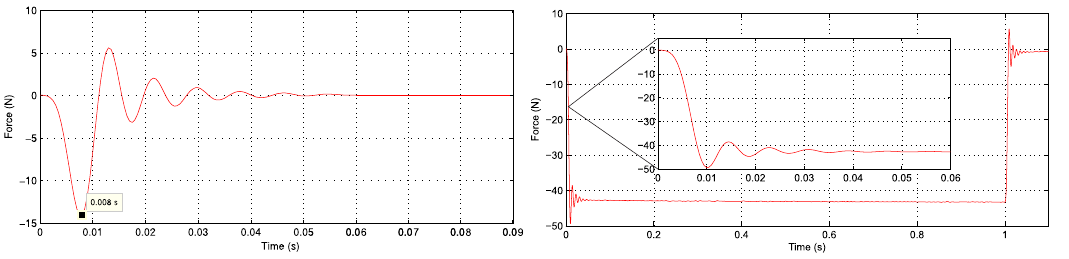
Figure 6. Impulse and step response of JR3 sensor with filter 125 Hz.